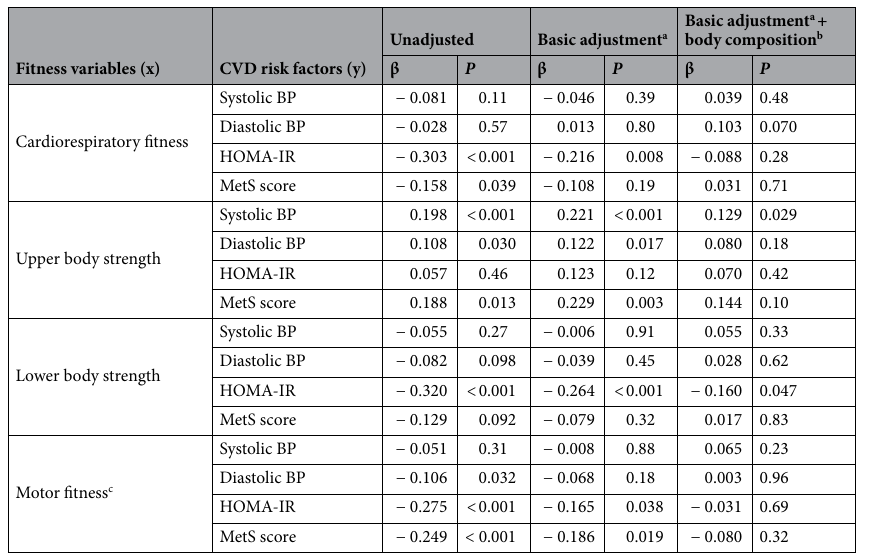
Table 4. Associations of physical fitness with cardiovascular risk factors in 9-year-old children. β, standardized regression coefficient; BP, blood pressure; CVD risk factors, cardiovascular disease risk factors; HOMA-IR, Homeostatic Model Assessment of Insulin Resistance; MetS score, metabolic syndrome score. a Adjusted for child’s age and sex, maternal educational level and maternal BMI. b Additionally adjusted for fat- mass index and fat-free mass index. c Since lower scores indicate higher performance, results are